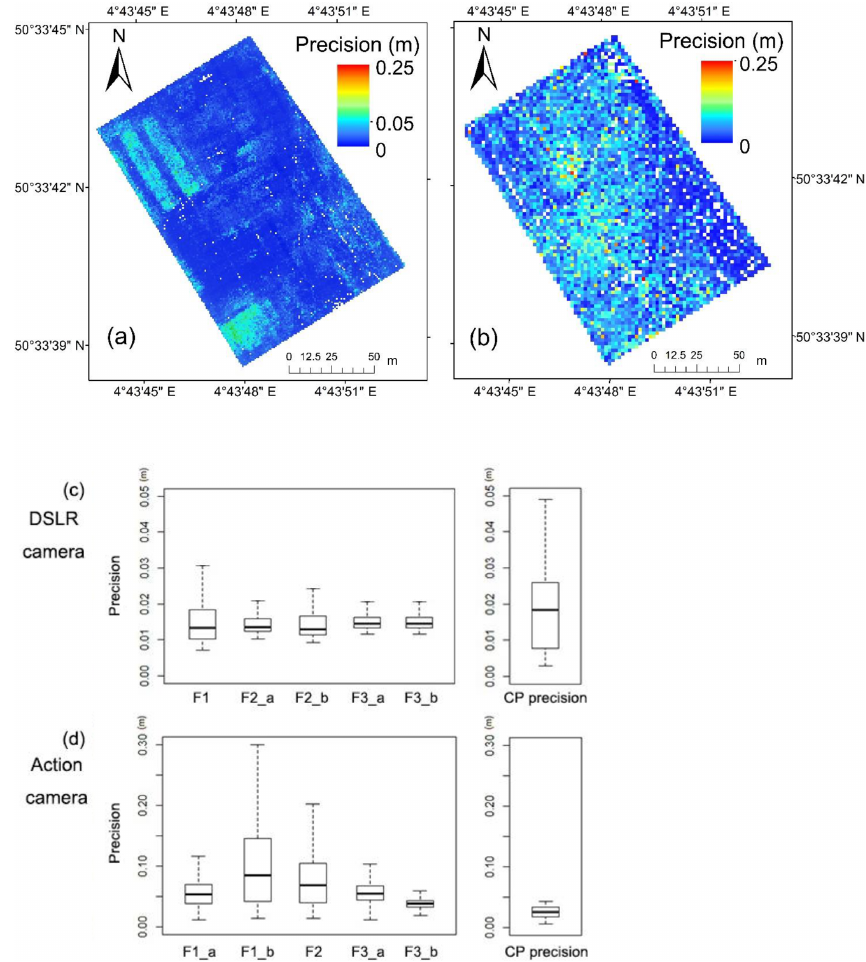
Figure 5. Precision maps derived from Monte Carlo simulation. (a) MC map of DSLR camera, dataset: F3_a. (b) MC map of action camera, dataset: F2_b. (c) Box plots of MC precision of DSLR surveys (area of interest). (d) Box plots of MC precision of action camera surveys (area of